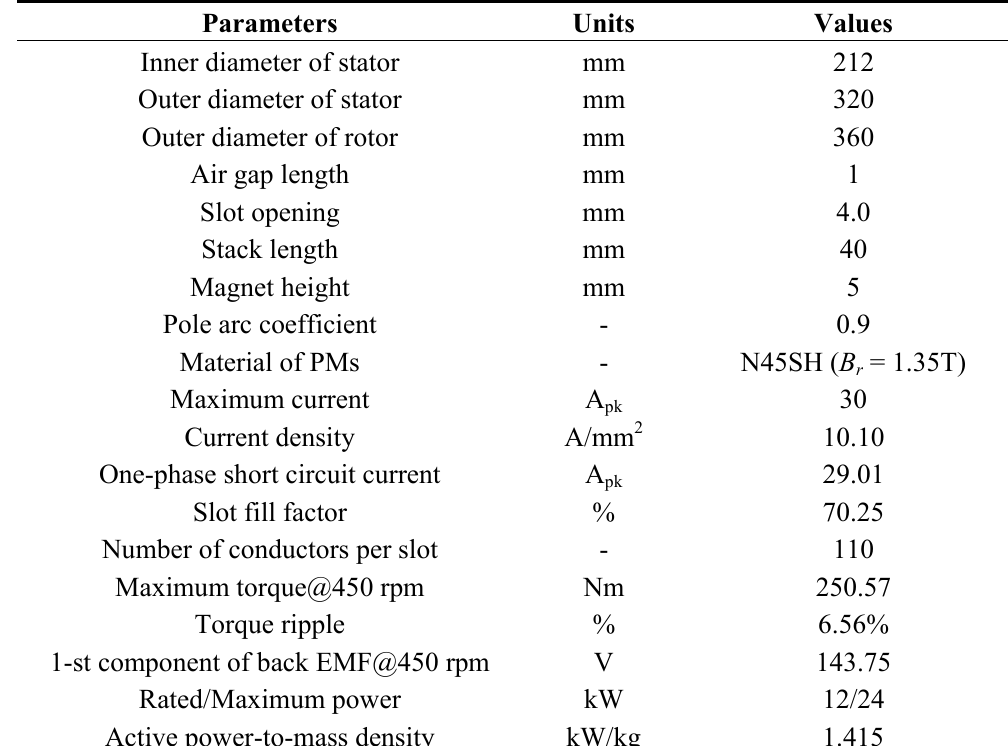
Table 7. Key parameters and dimensions of the optimal scheme.